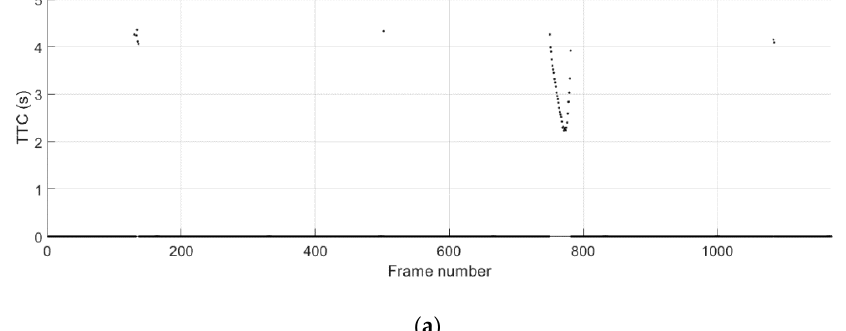
Figure 15b. The TTC results and the corresponding collision warning levels are presented in Figure 16. For all five cut-in maneuvers performed by the remote vehicle in the scenario 2, possible collision events are correctly predicted and corresponding collision warnings are provided.